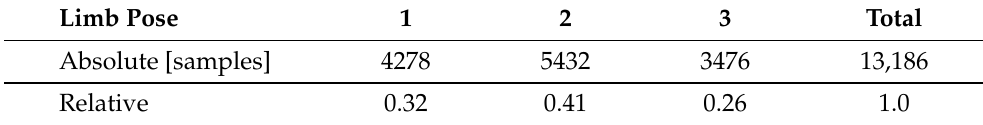
Table 4. Absolute and relative amount of adapted data points per limb position for all subjects.